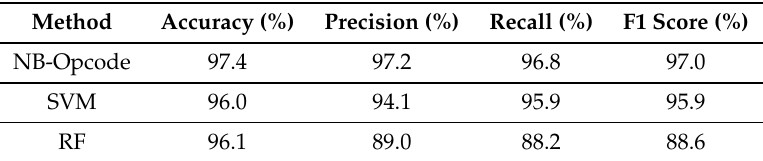
Table 4. Accuracy, precision, recall, and performance comparison. NB: naïve Bayes; RF: random forest; SVM: support vector